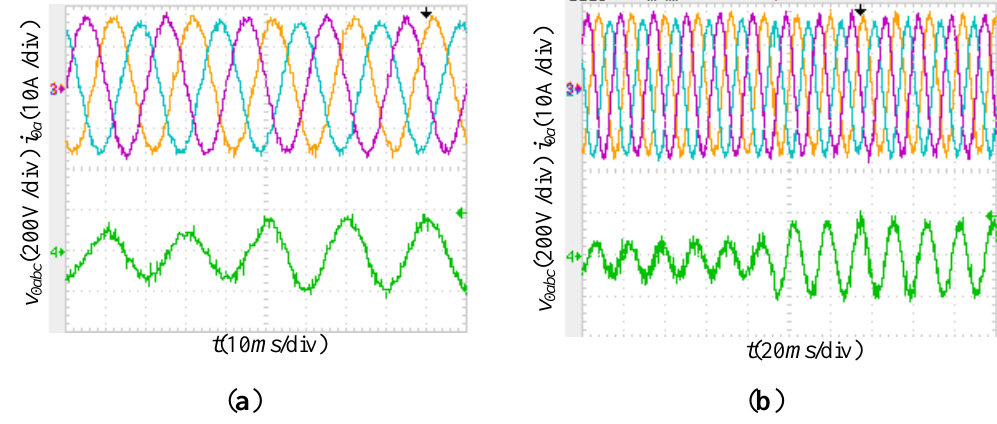
Figure 14. ( a ) Experimental results in grid-connected mode; ( b ) Experimental results in islanded